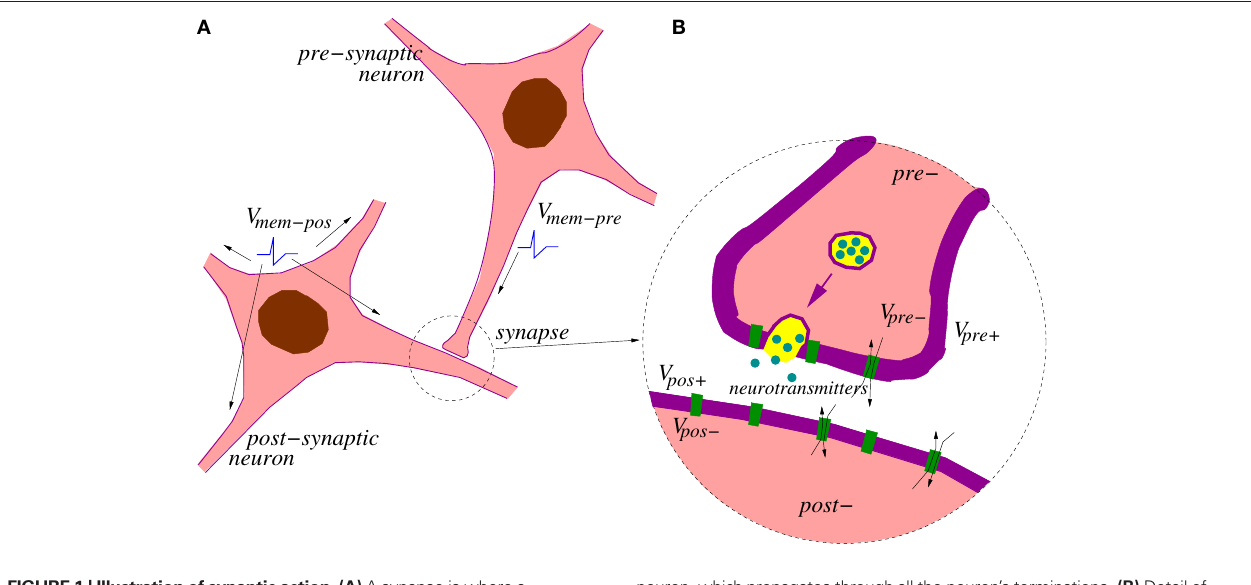
neuron, which propagates through all the neuron’s terminations. (B) Detail of Figure 1 | illustration of synaptic action. (A) A synapse is where a synaptic junction. The cell membrane has many membrane channels of varying pre-synaptic neuron “connects” with a post-synaptic neuron. The pre-synaptic nature which open and close with changes in the membrane voltage. During a neuron sends an action potential V traveling through one of its axons to mem − pre pre-synaptic action potential vesicles containing neurotransmitters are released the synapse. The cumulative effect of many pre-synaptic action potentials, into the synaptic cleft. generates a post-synaptic action potential at the membrane of the post-synaptic